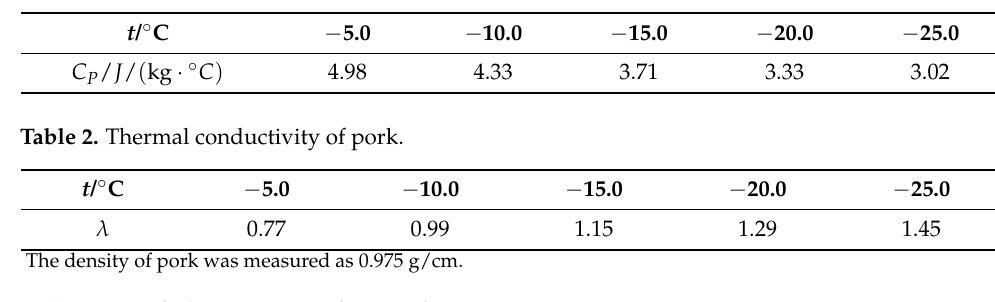
Table 1. Specific heat capacity of pork.